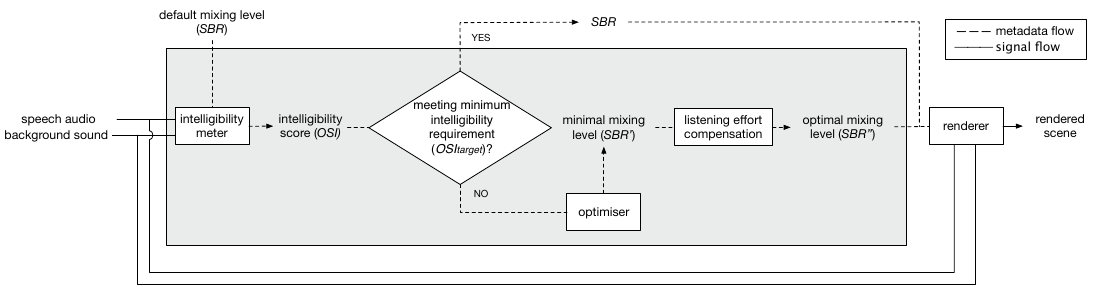
Figure 1. Schematic of a rendering system with intelligibility control. The current study focuses on the section in